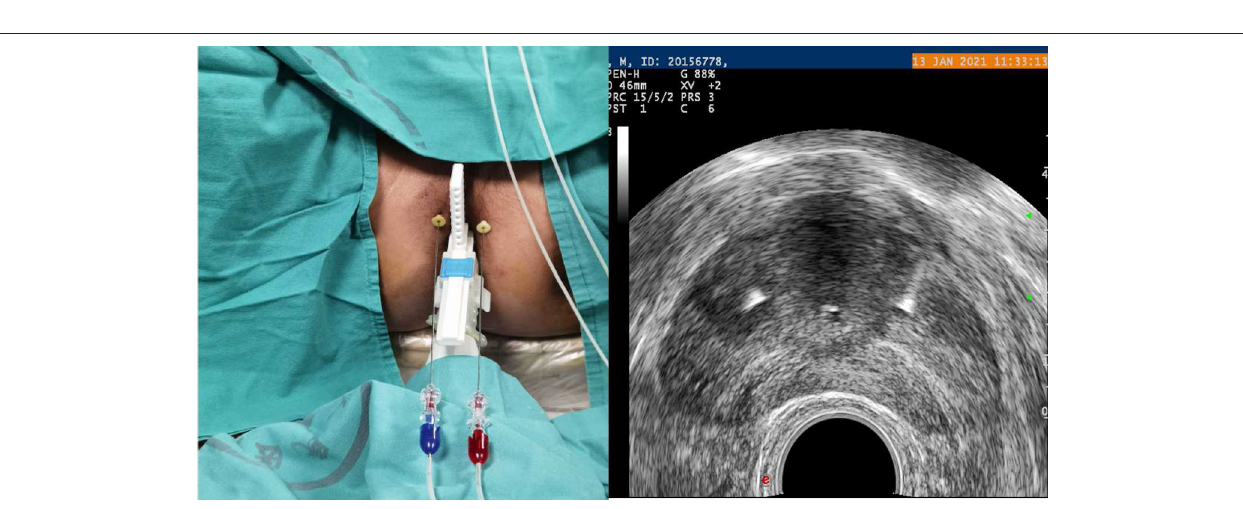
Frontiers in Surgery |